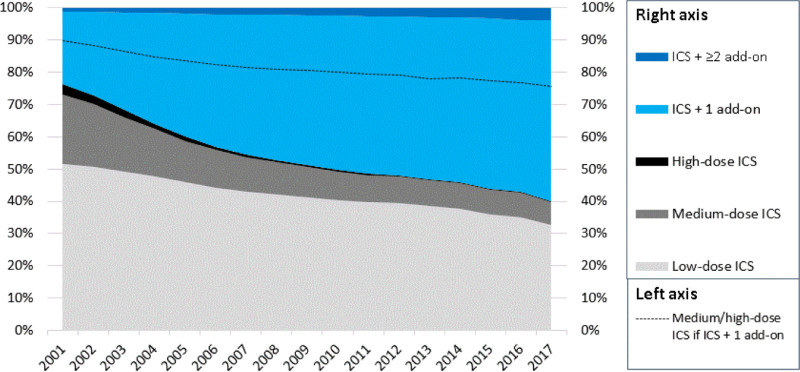
Prevalent asthma preventer prescriptions from across the UK, 2001–2017.The light blue area below the dotted line is the percentage of patients prescribed medium-dose or high-dose ICSs that are prescribed an ICS and 1 add-on therapy. Add-on therapy refers to LABA, LTRA, theophylline, or LAMA. ICS, inhaled corticosteroid; LABA, long-acting β2-agonist; LAMA, long-acting muscarinic antagonist; LTRA, leukotriene receptor antagonist.